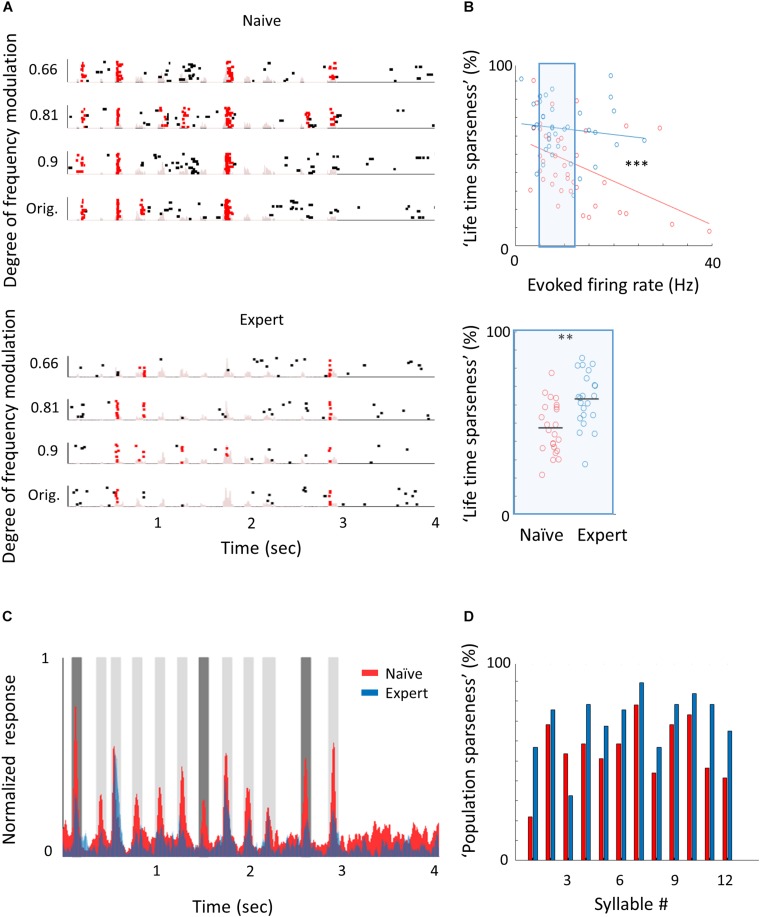
Learning complex sounds induces “sparsening.” (A) Representative examples of raster plots in response to 4 modulated wriggling calls from naïve (top) and expert (bottom) mice. Red lines indicate spikes in response windows that are significantly above baseline. The stimulus power spectrum shown in light pink in the background. (B) Top: Scatter plot of “lifetime sparseness” (along the vocalization, see methods) and evoked firing rate for individual neurons from naïve (red circles) and expert (blue circles) mice. Sparseness is significantly higher in the expert group (Mann–Whitney U test; ∗∗∗p < 0.001). The middle range of firing rate distribution (0.5 SD bellow and above the median) is indicated as a blue rectangle. Bottom: Lifetime sparseness for all cells from the middle range of the distribution shows significant difference between the groups (Mann–Whitney U test; ∗∗p = 0.001). (C) Average normalized PSTHs calculated from all neurons in response to the original WC. Data are shown overlaid for naïve (red) and expert (blue) mice. In expert mice, only syllables 1, 7, and 11 evoked significantly weaker responses as compared to naïve mice (dark gray bars, Mann–Whitney U test followed by Bonferroni correction; p = 0.03, 0.001, 0.03). (D) Population sparseness (% of cells that evoked a significant evoked response to a given syllable) of all neurons in naïve (red) and expert (blue) for the different syllables in the call.